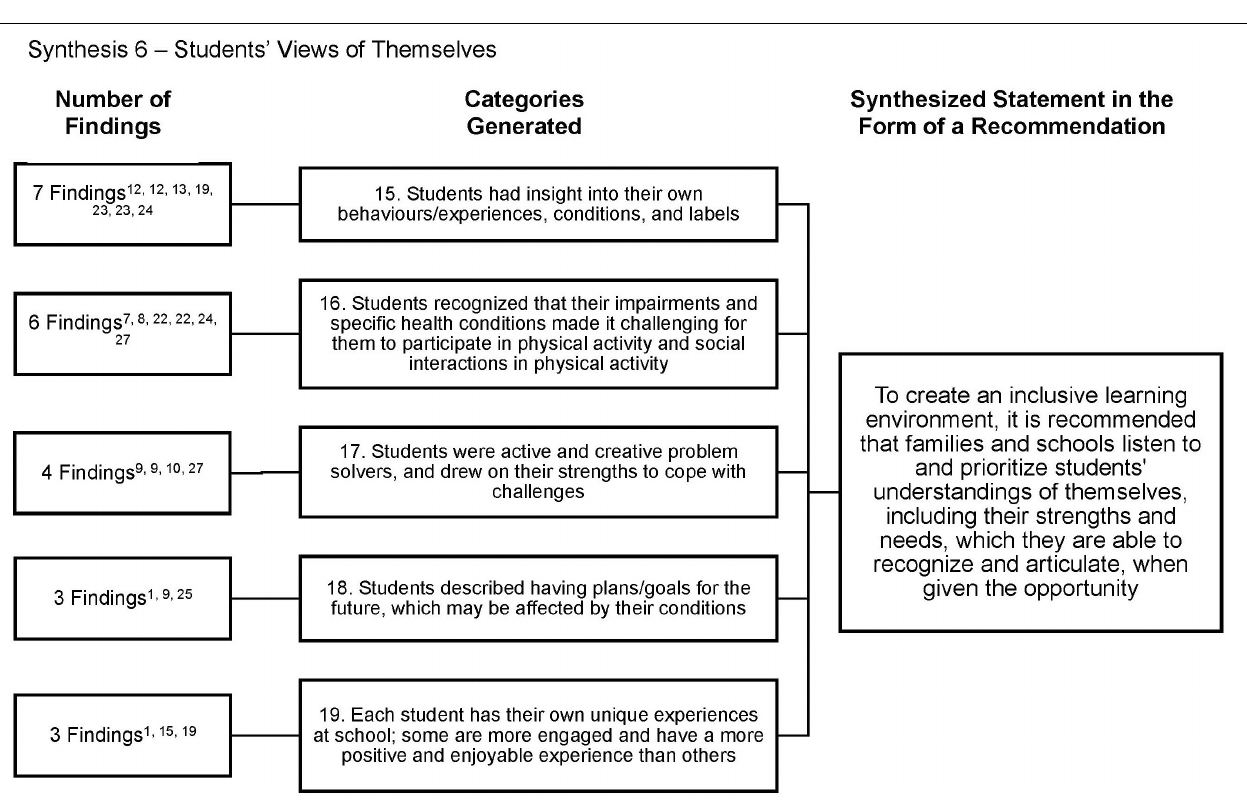
Frontiers in Education |